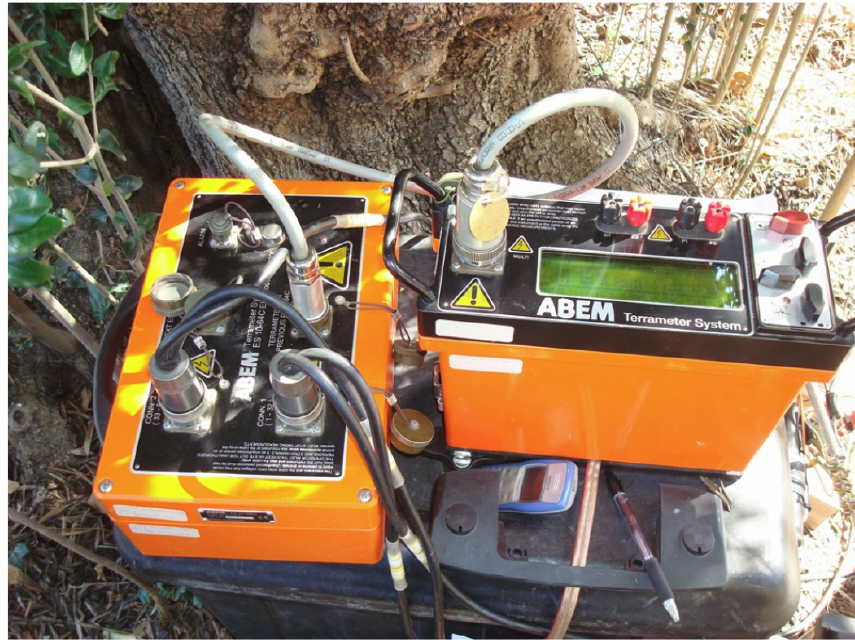
Fig. 8. The Geo-Resistivimeter used in our survey, a Terrameter SAS 1000, built by Abem Instrument (Sweden) (photo A. M. Marras).